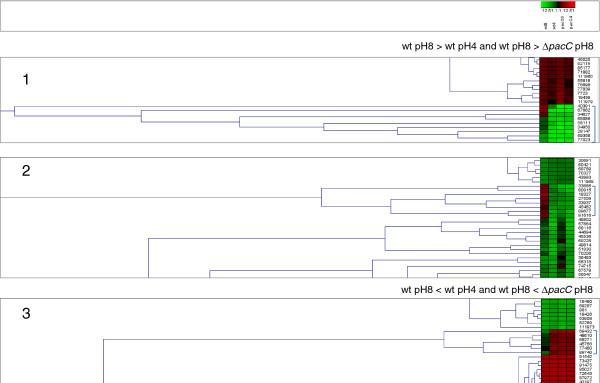
Representative results of cluster analysis. Average microarray signals were clustered (Genesis, http://genome.tugraz.at/).